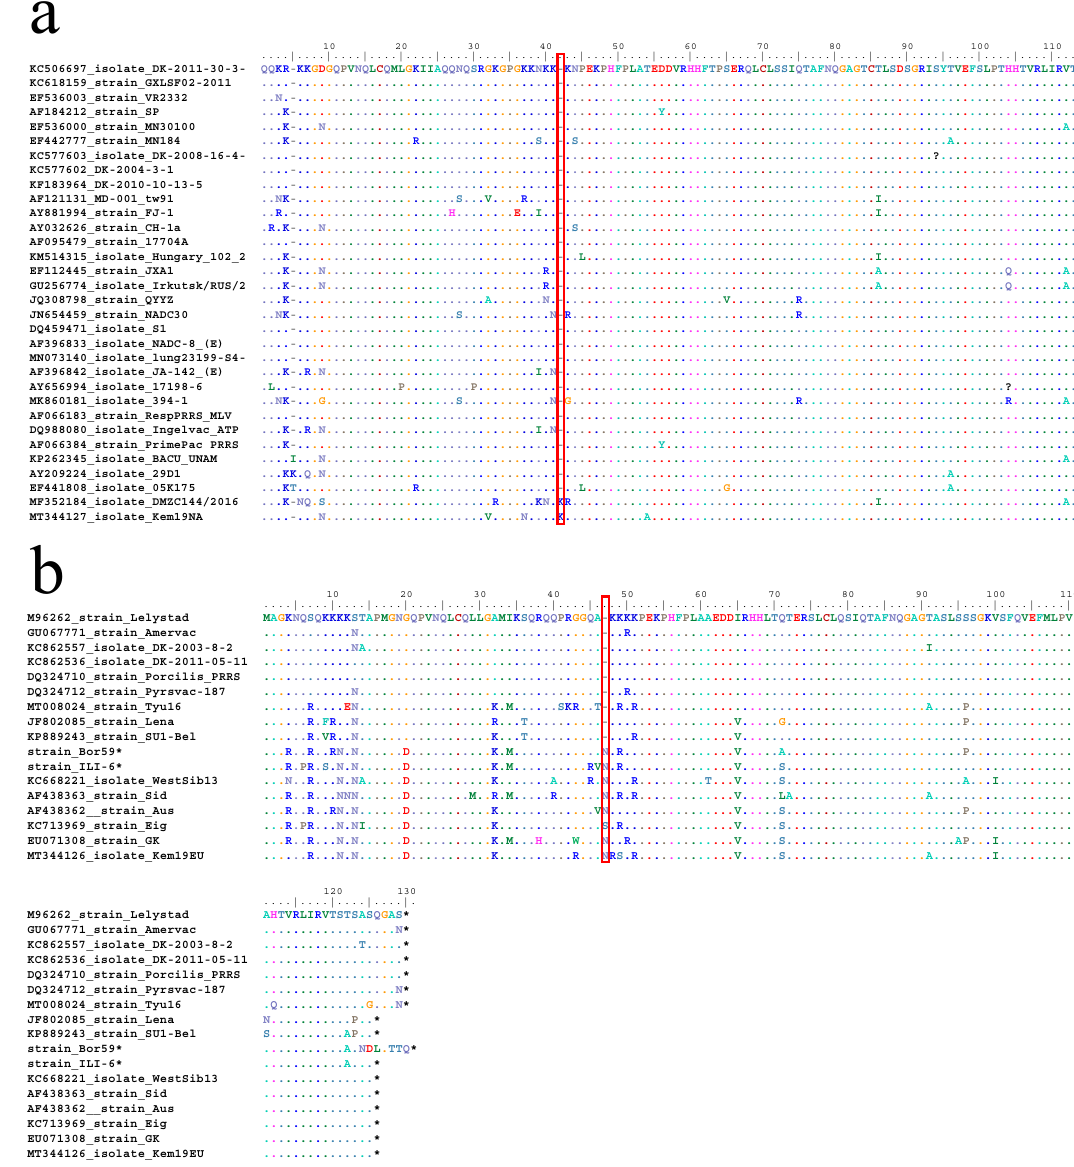
Figure 5. Partial alignment of amino acid sequences derived from ORF7 of PRRSV2 ( a ) and complete alignment of amino acid sequences derived from ORF7 of PRRSV1 ( b ) strains. Dots and hyphens represent identical amino acid positions and gapped positions, respectively. The red box denotes insertions in the investigated strains. The sequences of the strains indicated by an asterisk ( * ) were kindly provided by Prof. Dr. Tomasz Stadejek (Warsaw University of Life Sciences, Poland) and Dr. Sara Botti (Parco Tecnologico Padano, Italy).